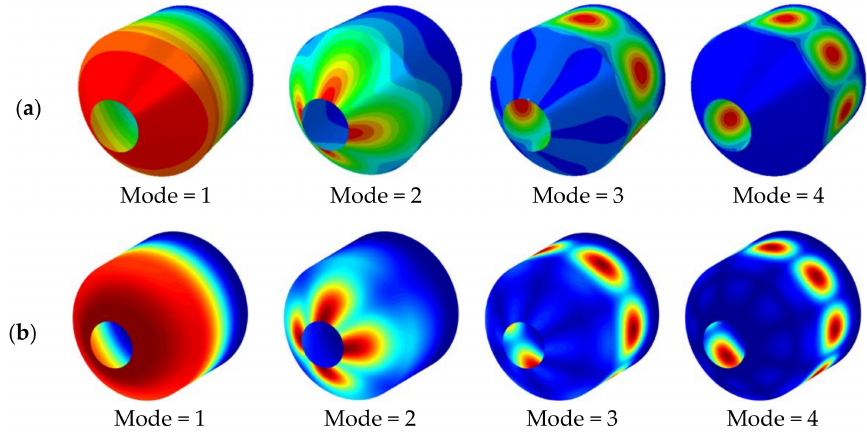
Figure 3. Mode shapes of laminated combined conical-cylindrical shell with FC boundary condition ( m = 1, ϕ = π /4) ( a ) ABAQUS ( b )